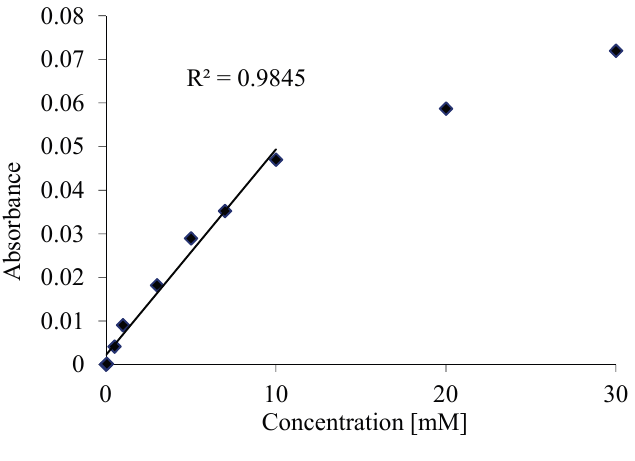
Figure 4. Glucose absorbance calibration curve after 10 min